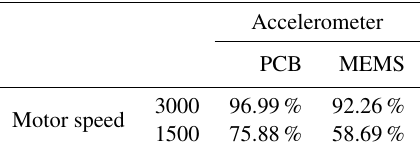
Table 10. Accuracy values for classifier training with ramp-up data and additional offset.